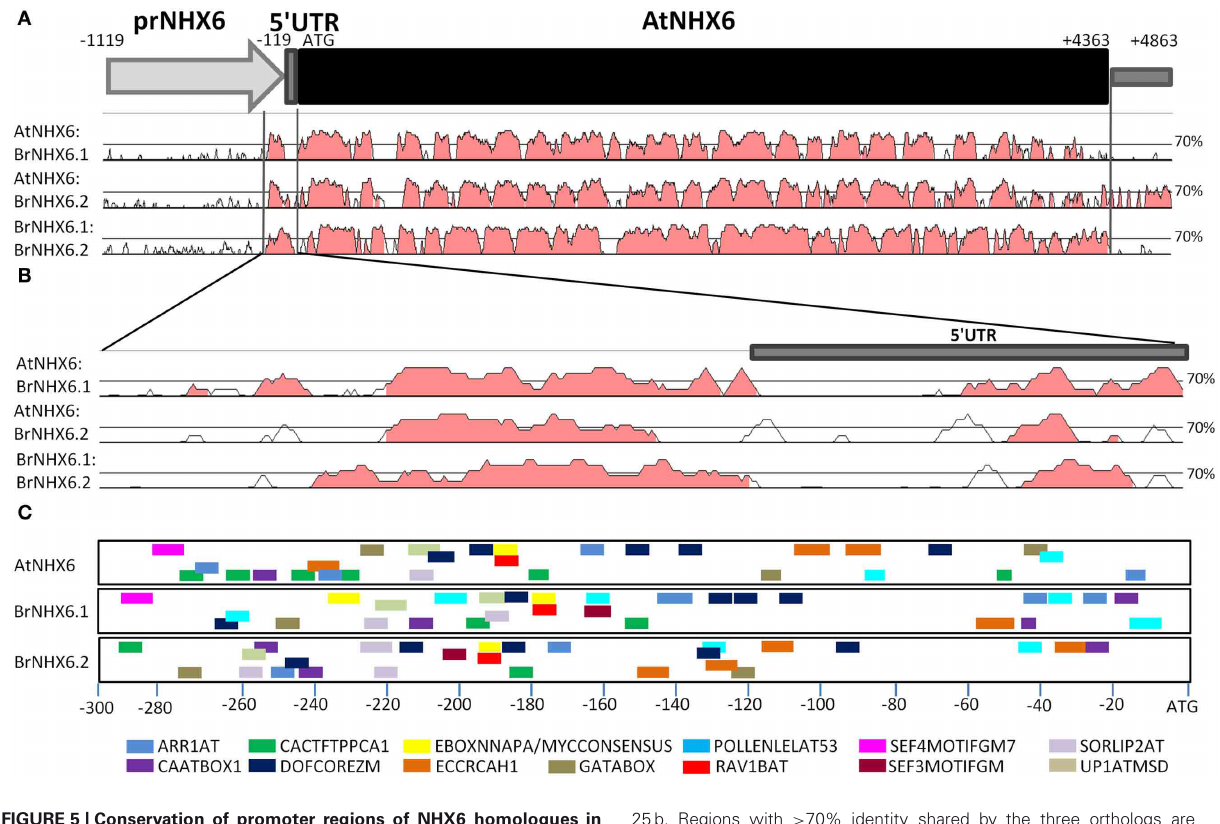
25b. Regions with > 70% identity shared by the three orthologs are shaded in pink. (C) Positions of known plant cis -acting regulatory elements which are common to all three genes are shown as colored